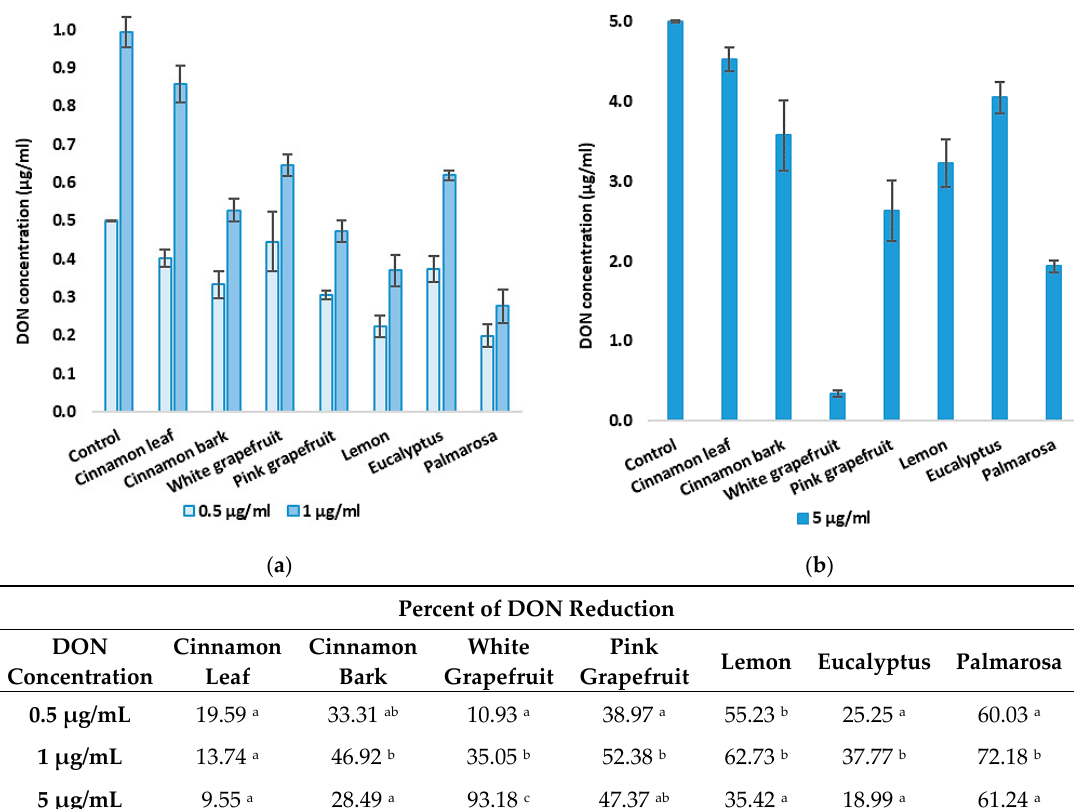
Figure 1. The effect of deoxynivalenol concentration ( a —0.5 and 1 μ g/mL; b —5 μ g/mL) on its Figure 1. The e ff ect of deoxynivalenol concentration (( a )—0.5 and 1 µ g / mL; ( b )—5 µ g / mL) on its